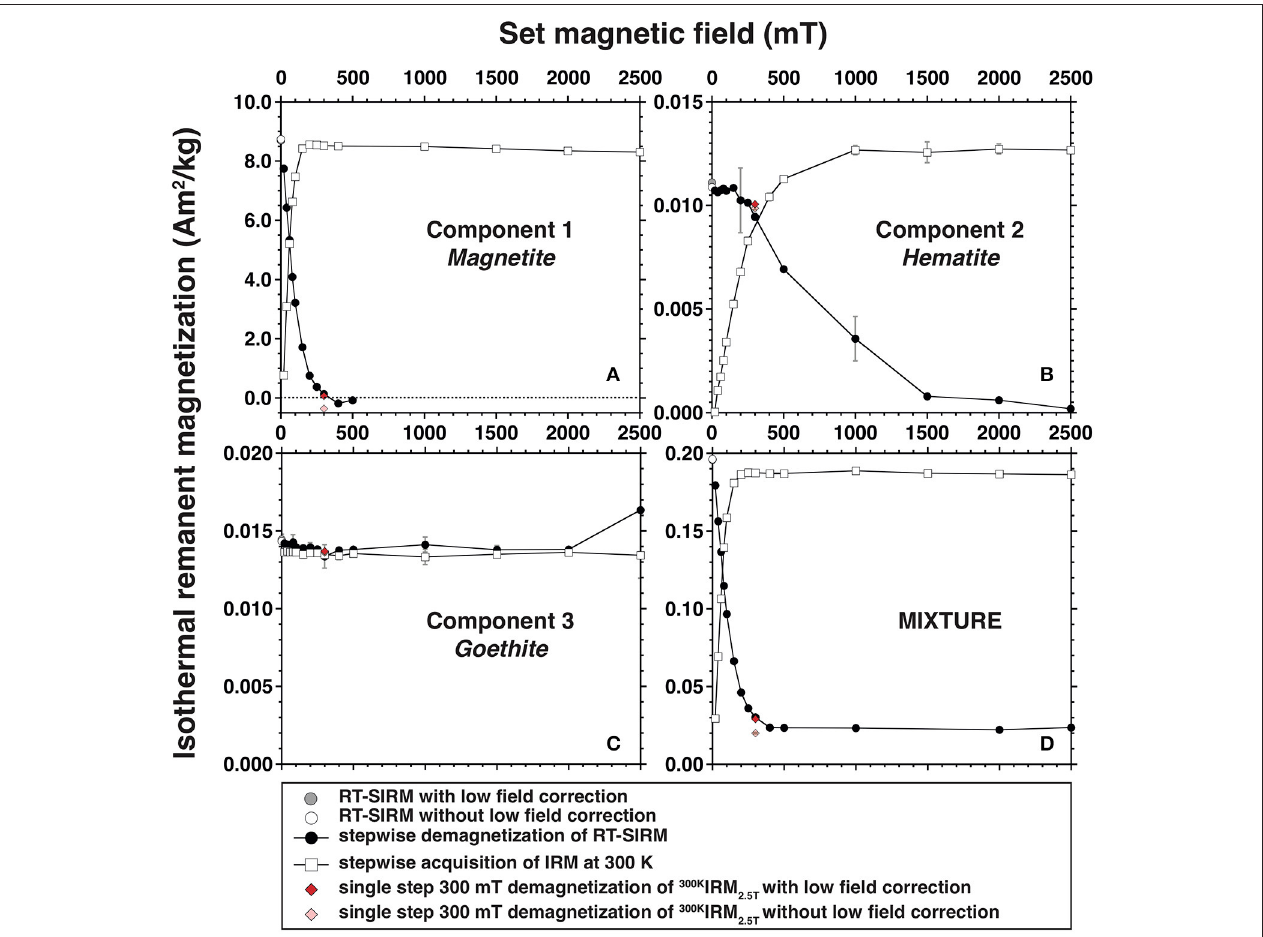
FIGURE 3 | Experiments aimed at testing the demagnetization efficiency of the superconducting magnetic’s oscillation mode for the individual components, magnetite (A) , hematite (B) , goethite (C) , and the mixture (D) . First a RT-SIRM was imparted in a 2.5 T field (gray and white circles) and stepwise demagnetized by charging the superconducting magnet in the no-overshoot mode and back to zero in the oscillation mode from increasingly higher fields (black circles). Second, each sample was subjected to a stepwise IRM acquisition up to 2.5 T (white squares) followed by single step demagnetization from 300 mT to zero (red and pink diamonds). The low field correction corresponds to a sequence using the AC coil to cancel the magnet residual field. Each data point is the average of three measurements and its standard deviation. MPMS sequence is provided as Supplementary